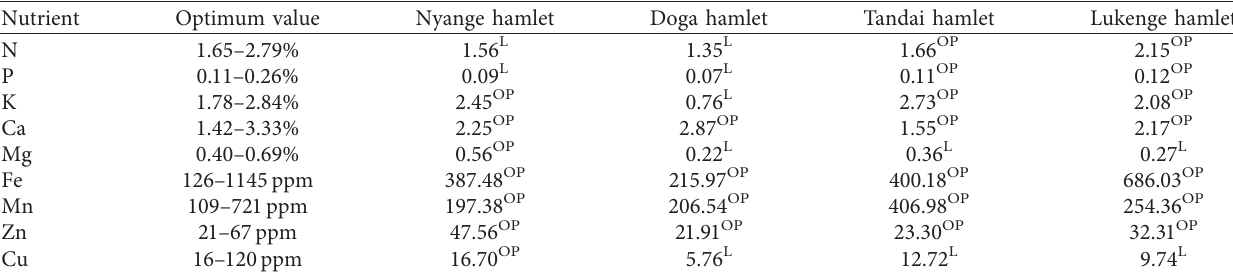
Table 2: Concentration of nutrient elements in mature pepper